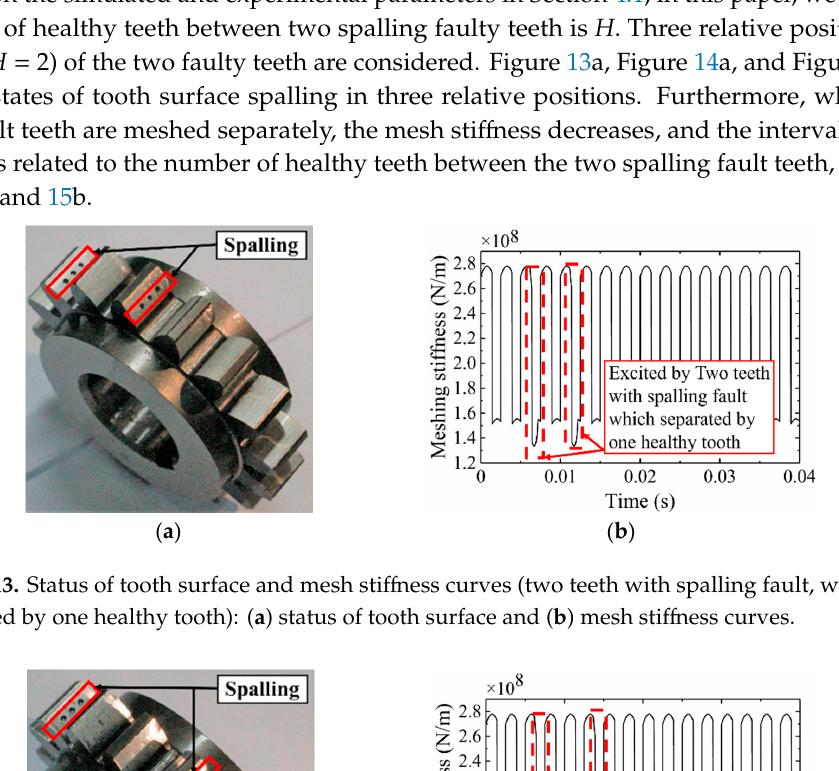
Figure 12. The simulated and experimental signal along the line of action (adjacent teeth spalling fault): ( a ) simulated signal, ( b ) simulated frequency signal, ( c ) experimental signal, and ( d ) experimental frequency signal.